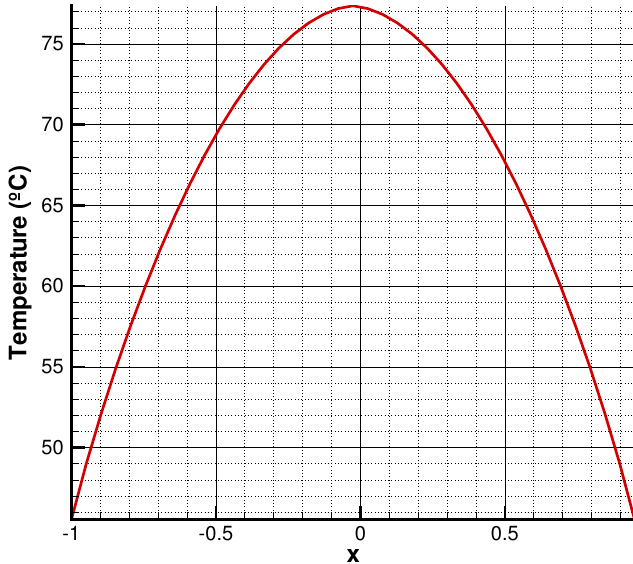
Figure 4. Stationary solution of the EBM model, without coupling with the deep ocean, for Q =